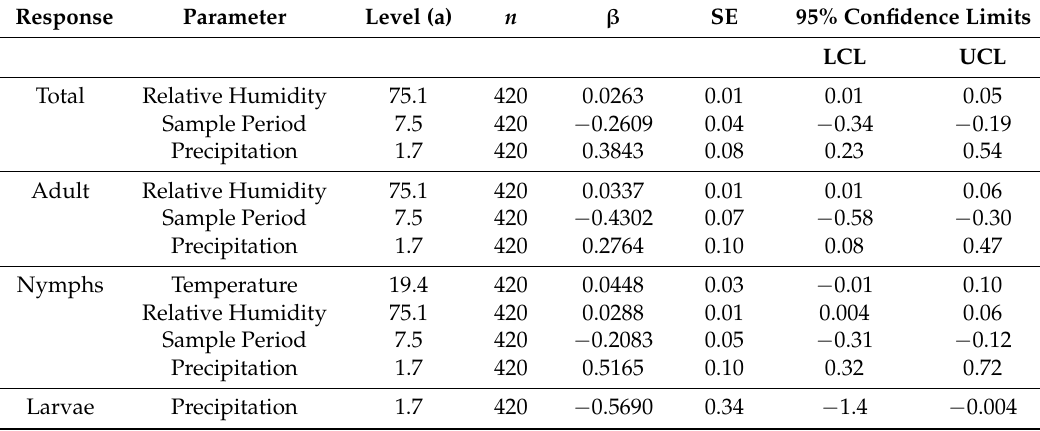
Table 4. Coefficient ( β ), standard error (SE) and 95% confidence limits of significant weather variables on presence of Amblyomma americanum (L.) collected in